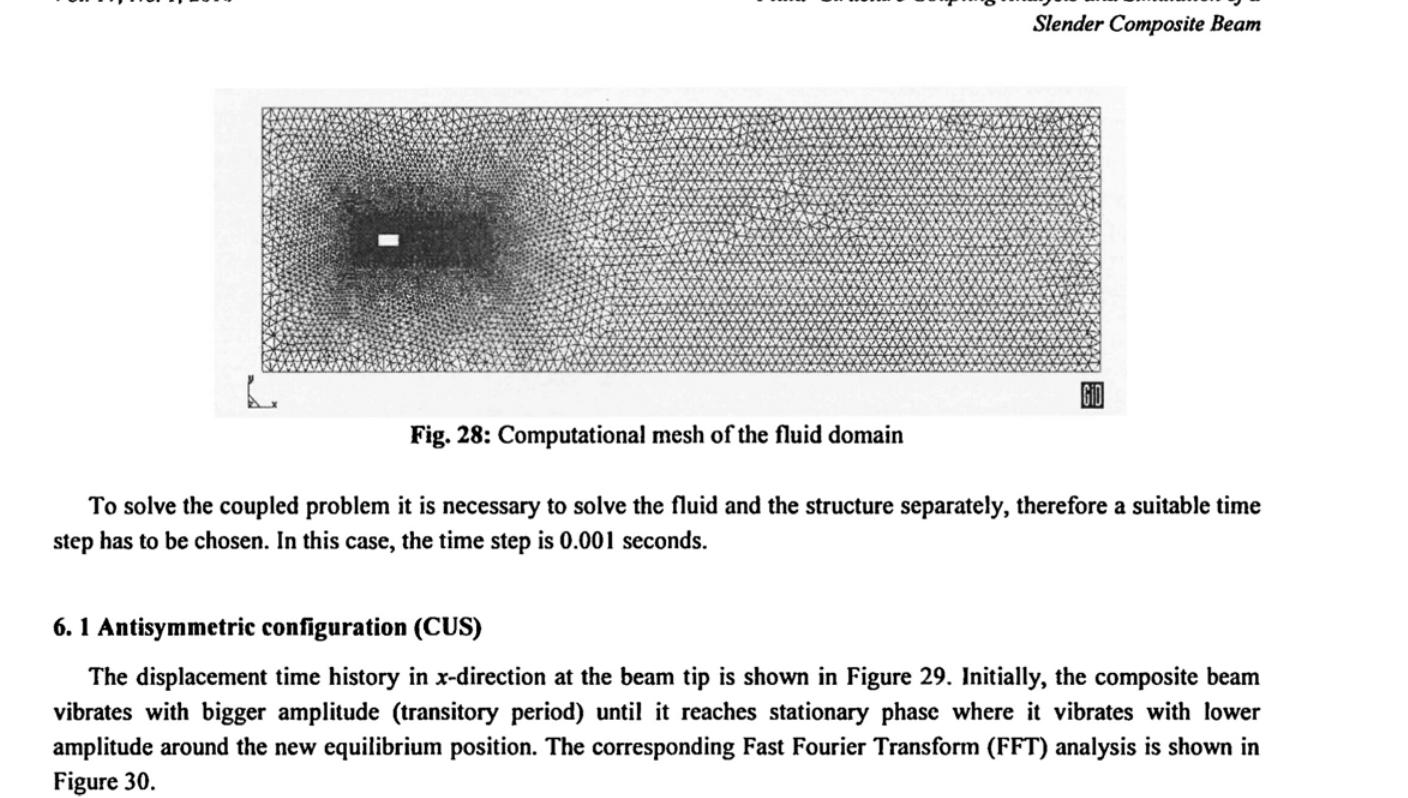
Fig. 29: Displacement time history in ^-direction